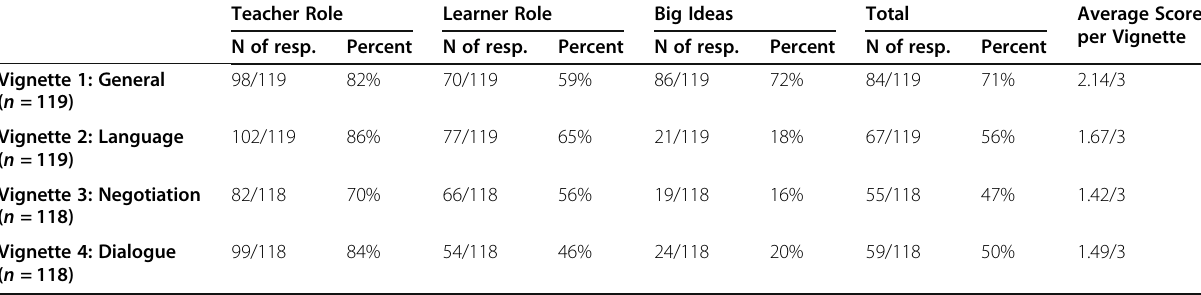
Table 3 Summary of Adaptiveness Vignette Scores: Number and Percent of Respondents Addressing Each Area ( n =